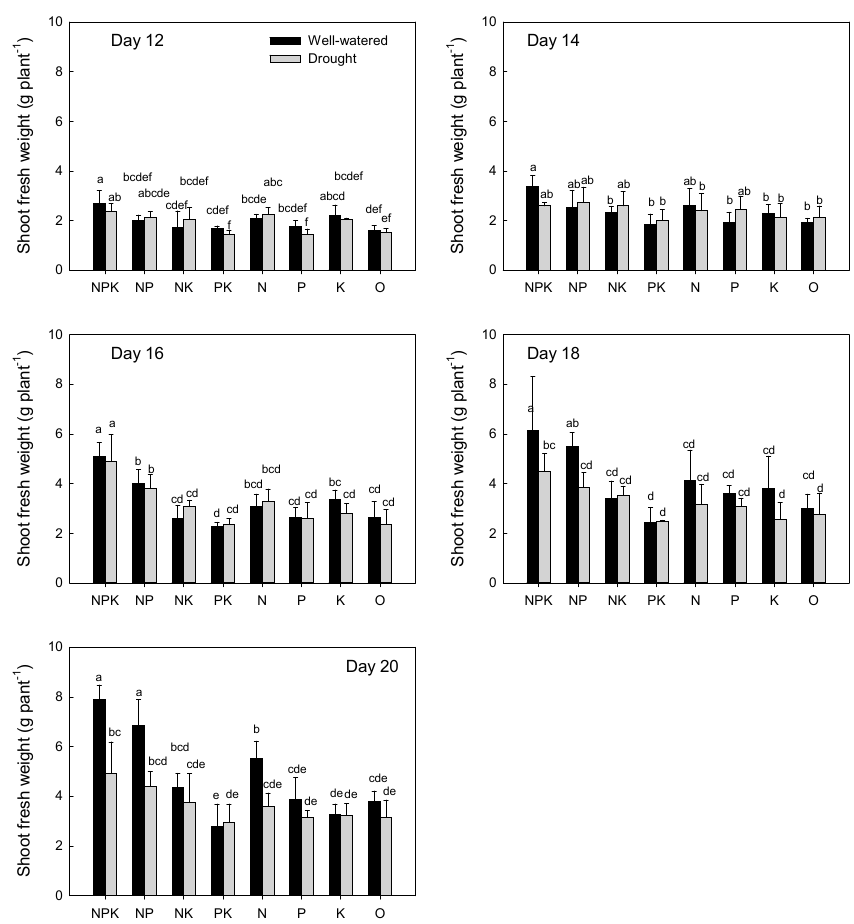
Figure 3. Interactive effects of drought and the N, P and K nutrients applied individually or in combination, or with no nutrient application (0) on the shoot fresh weight of the maize seedlings at days 12, 14, 16, 18 and 20 after sowing. The error bars represent the standard errors of the mean ( n = 3) and fit within the plot symbol if not visible. Means accompanied by different letters are significantly different at p < 0.05.